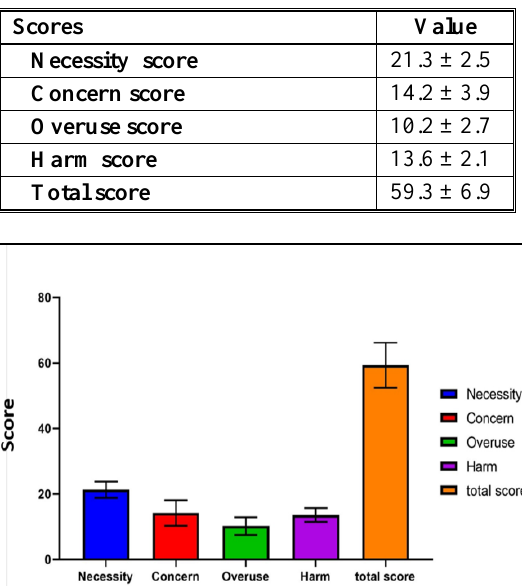
Table 3. Beliefs about medicines questionnaire